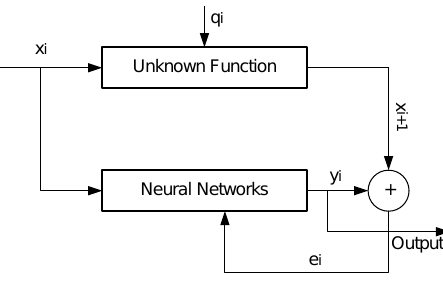
Figure 1. Design nural networks (NN) stochastic model identification